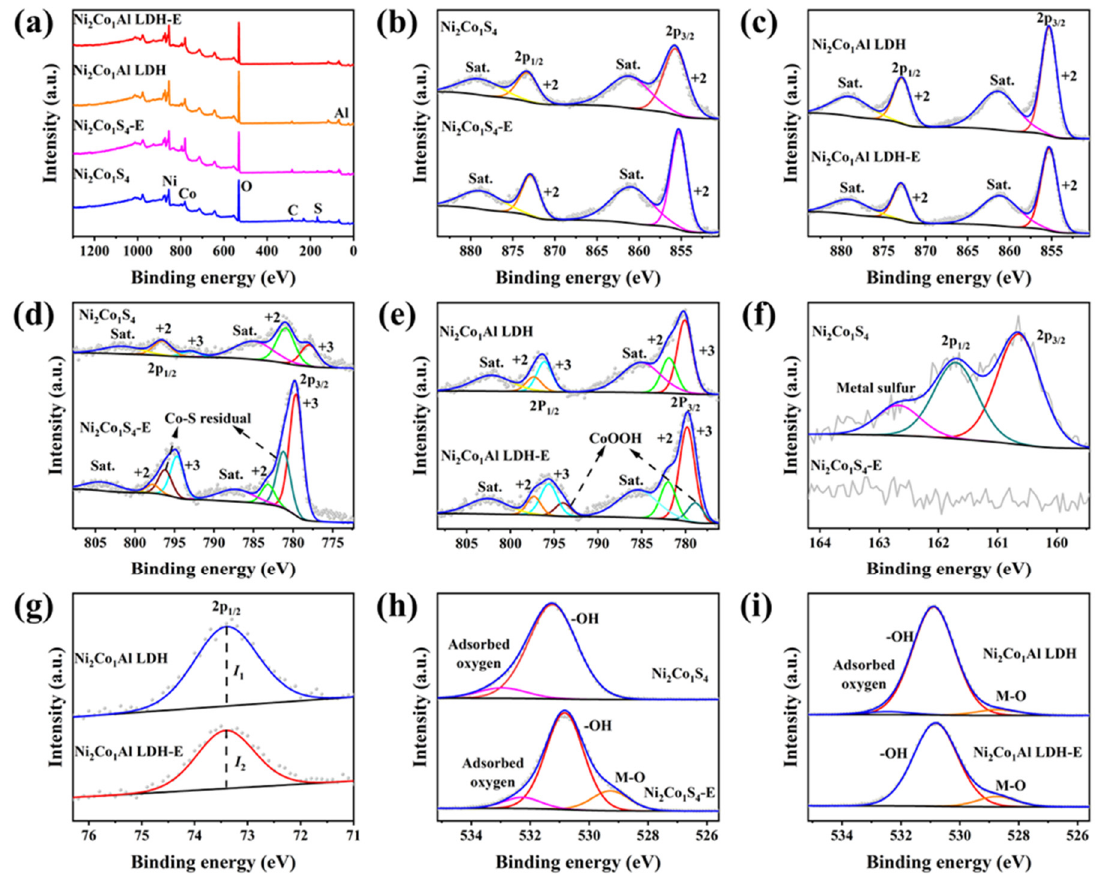
Figure 2. ( a ) The XPS spectra of Ni 2 Co 1 S 4 , Ni 2 Co 1 S 4 -E, Ni 2 Co 1 Al, and Ni 2 Co 1 Al-E, ( b ) Ni 2p of Ni 2 Co 1 S 4 , Ni 2 Co 1 S 4 -E, ( c ) Ni 2 Co 1 Al LDH and Ni 2 Co 1 Al LDH-E, ( d ) Co 2p of Ni 2 Co 1 S 4 and Ni 2 Co 1 S 4